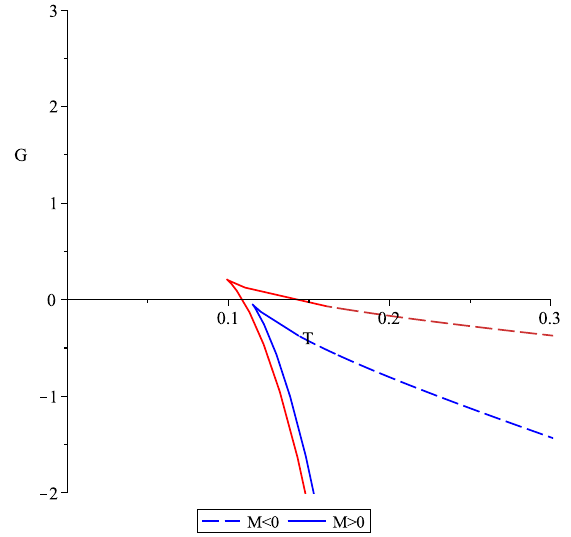
Figure 4 . Cusp Structure for vanishing charge. Setting e = g = 0 , we observe a cusp structure for all values of ‘ and n . Here we set ‘ = 3 ; n = 1 . 3 and n = 0 . 7 are the blue and red curves respectively, with the dash corresponding to M < 0